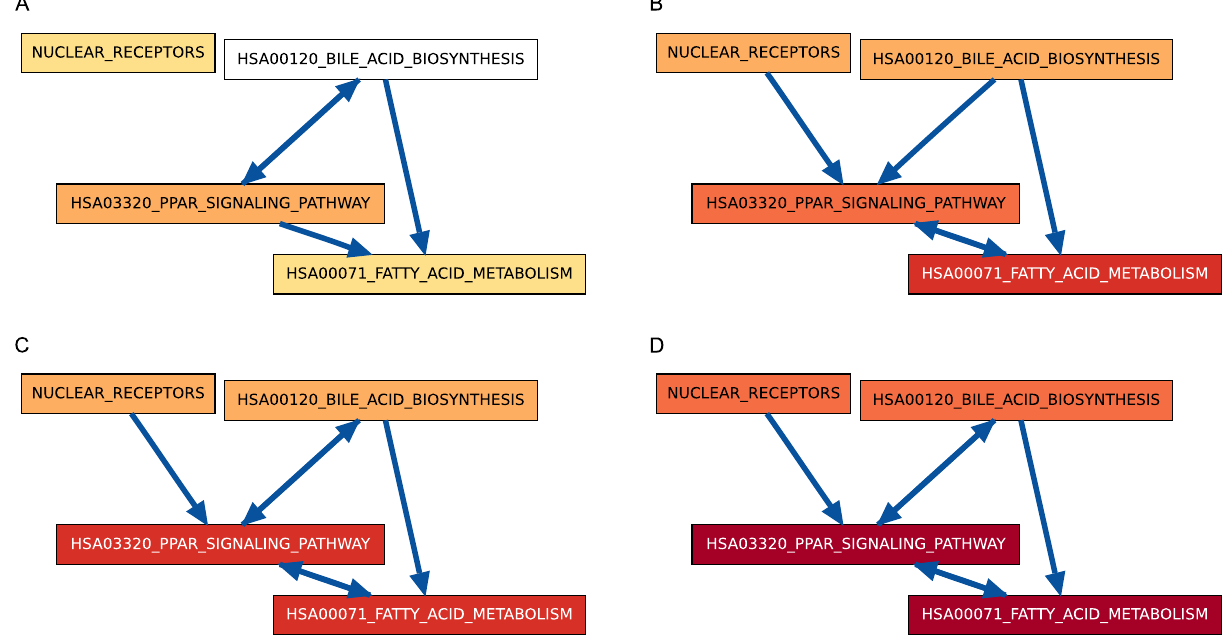
Figure 8. Subgraphs of the CBPLNs involving nuclear receptors and the PPAR signaling, bile acid biosynthesis, and fatty acid metabolism pathways, on days 1 (A), 2 (B), 3 (C), and 8 (D).